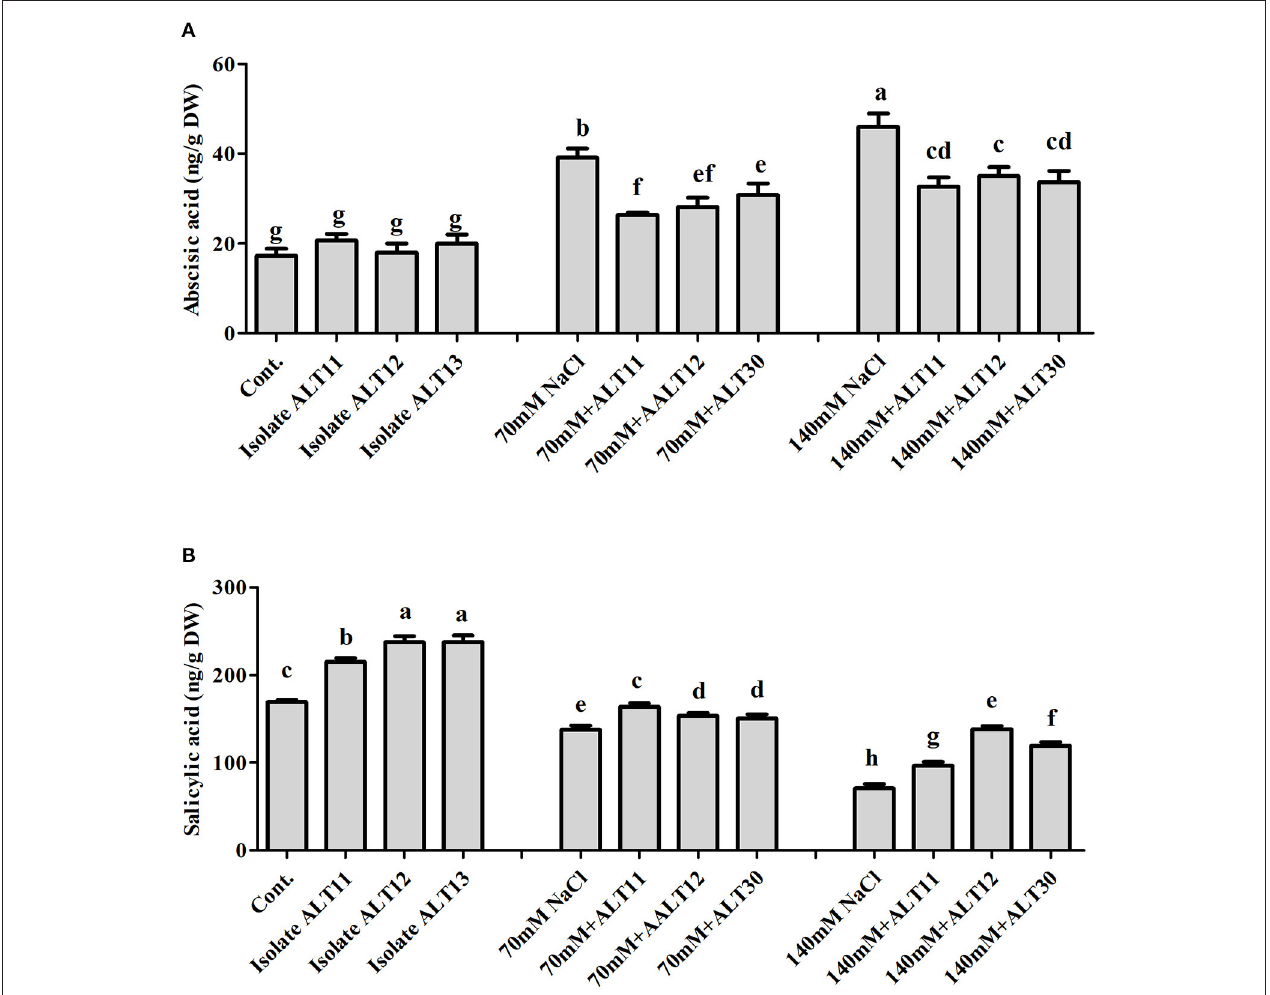
FIGURE 3 | Endogenous abscisic acid (ABA) and salicylic acid (SA) quantification in rice plants inoculated with isolates ALT11, ALT12, and ALT30 under standard salinity and NaCl stress (70 and 140mM). (A) Demonstrates ABA and (B) shows the amount of SA under normal conditions and NaCl stress. Different letters indicate significant differences between the mean values of three replicates ± standard